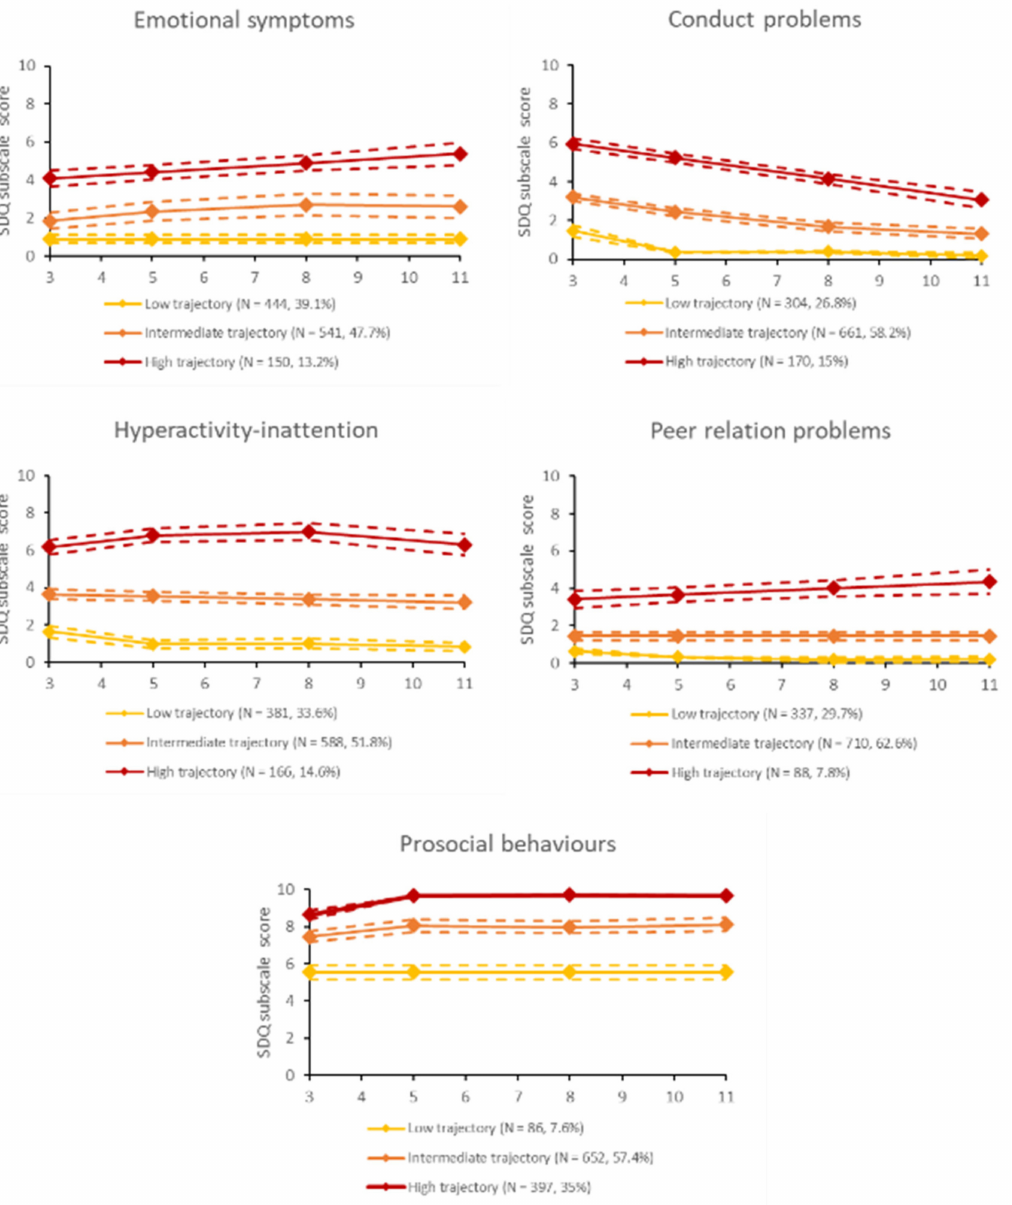
Figure 2. Trajectories of children’s emotional and behavioural symptom scores measured through parent-reported Strengths and Difficulty Questionnaires from ages 3 to 11 years (EDEN cohort study, n =